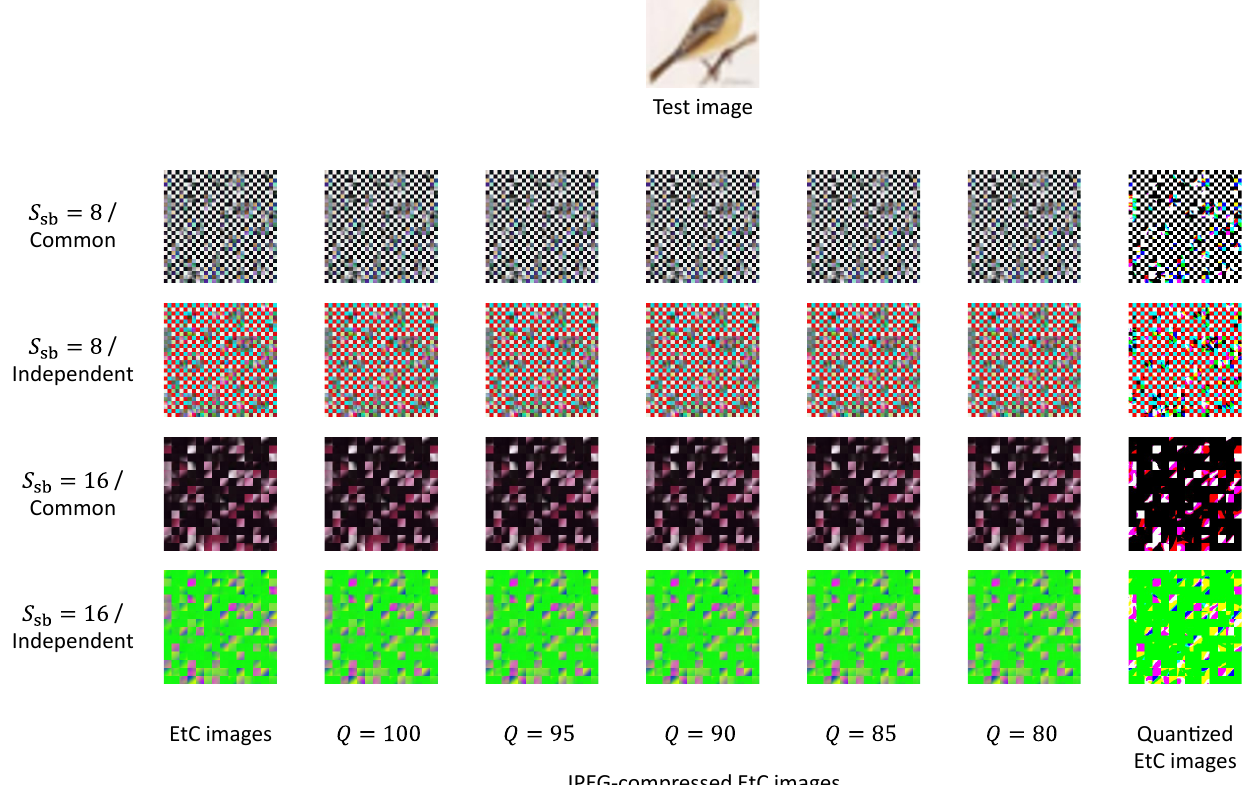
Figure 9. EtC, JPEG-compressed EtC, and quantized EtC images for a single test